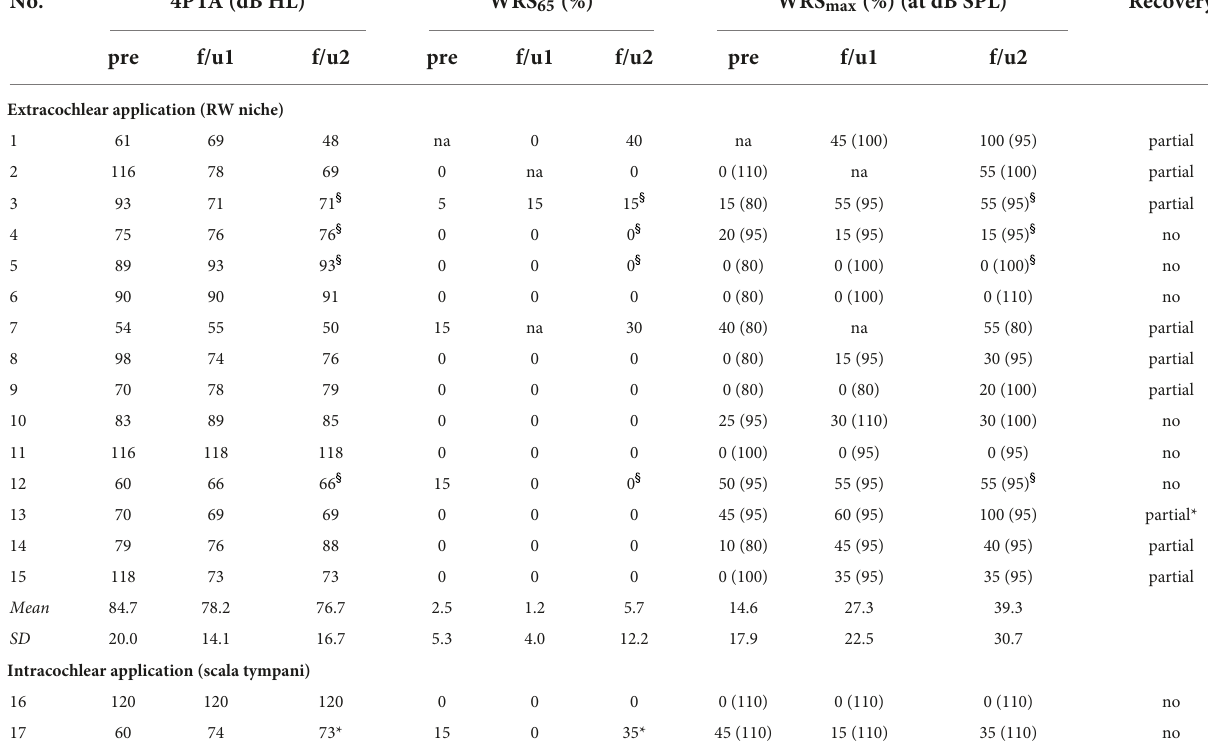
TABLE 2 Summary of audiologic outcome